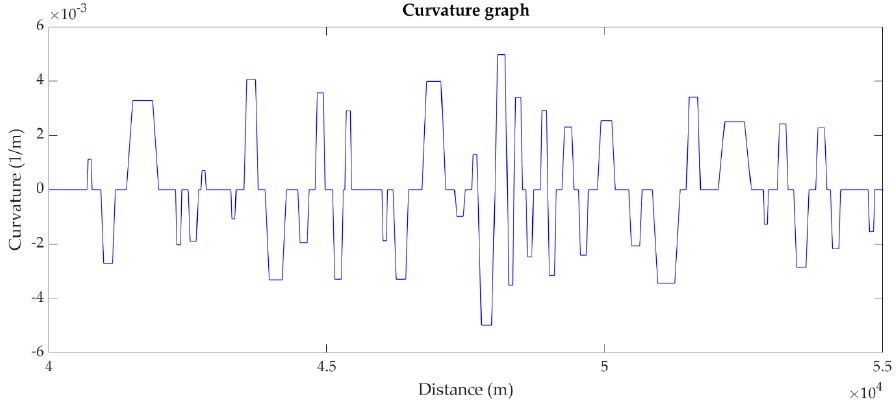
Figure 13. Curvature graph of the HWY 4—from the distance 40 km to the distance 55 km.